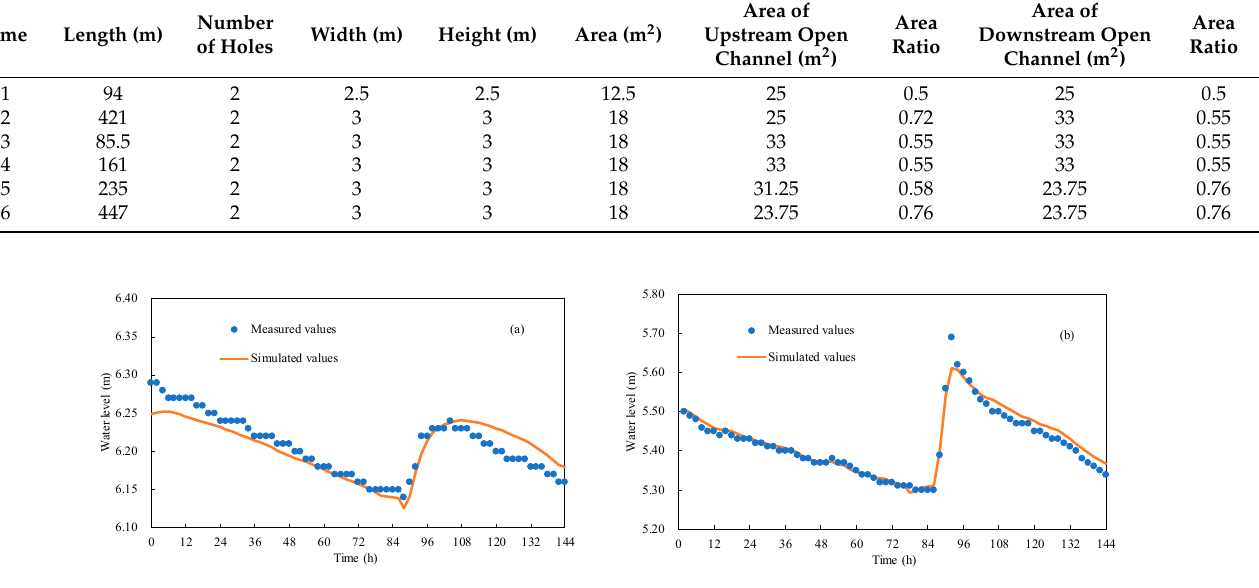
Figure 5. Water level simulation results at the S5 ( a ) and S6 ( b ) inlets.